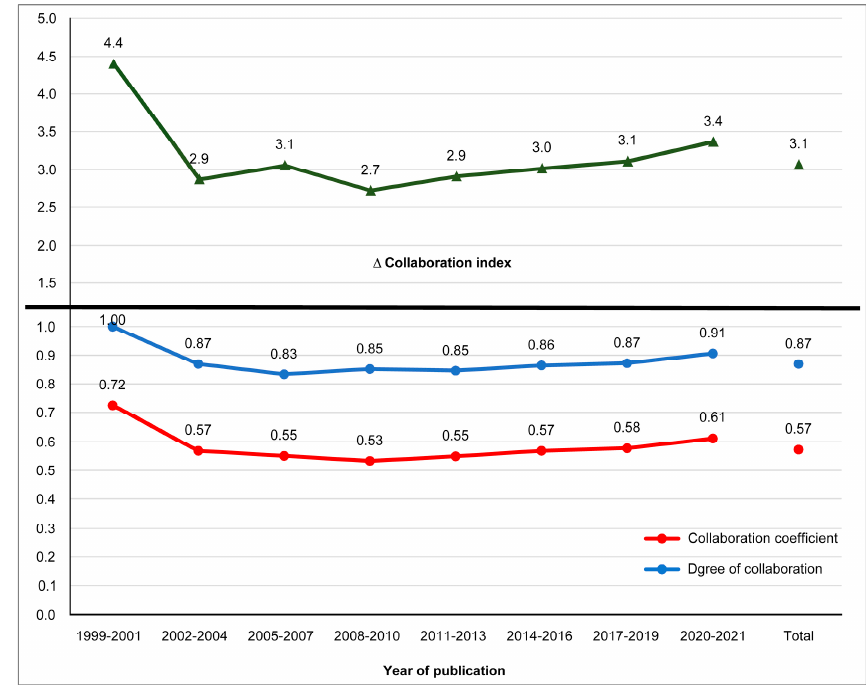
Figure 13. Collaboration index (CI), degree of collaboration (DC) and collaboration coefficient (CC) of authors (1999–2021).